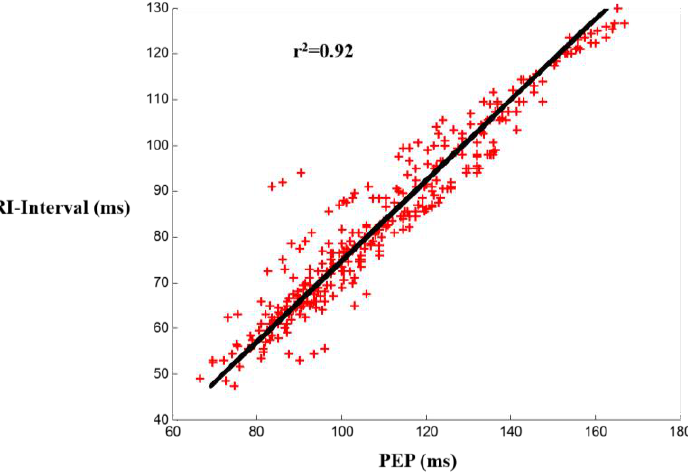
Figure 5. Linear regression fit for head-to-foot force plate BCG vs. PEP during recovery among all 17 subjects.